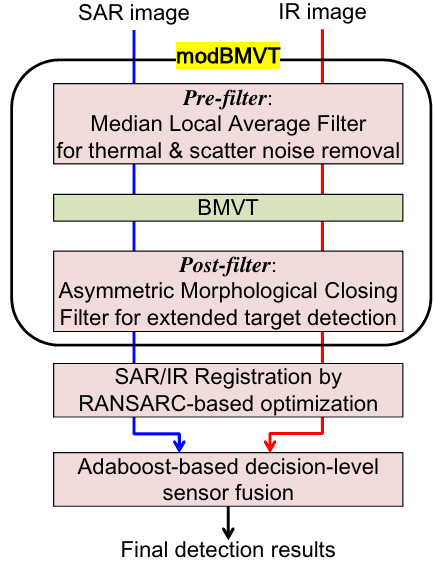
Figure 6. Proposed decision level fusion-based extended SAR/IR target detection using modBVMT and RASARC-based